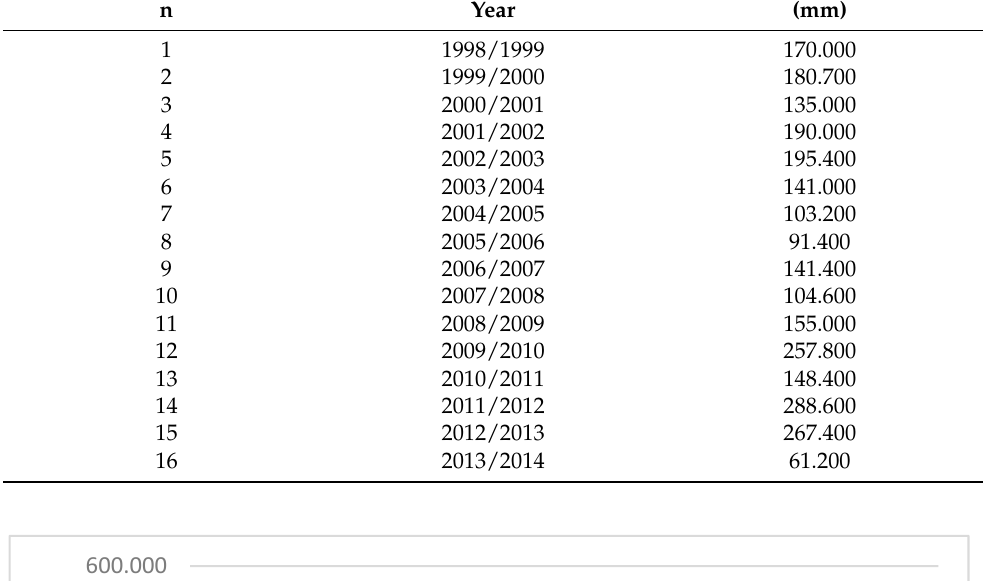
Table A4. Precipitation historical data (Source: [29]).